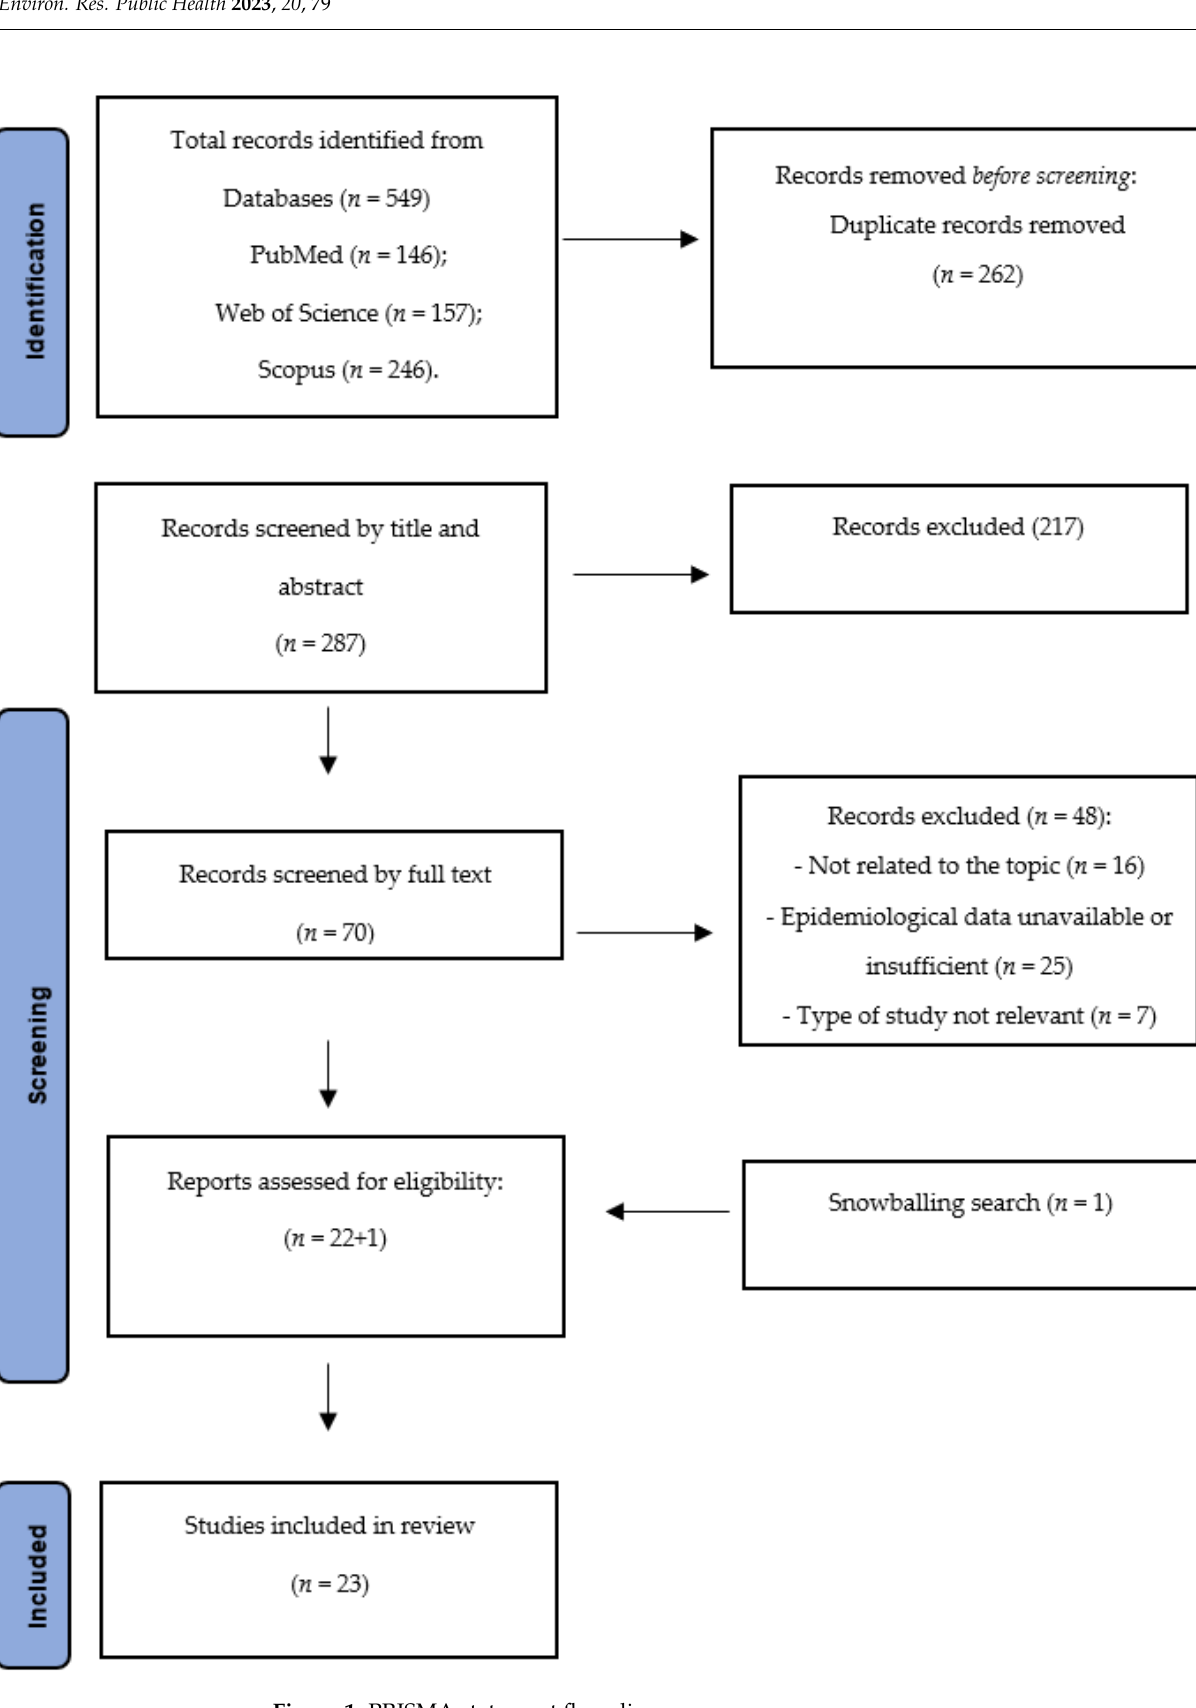
Figure 1. PRISMA statement flow diagram.